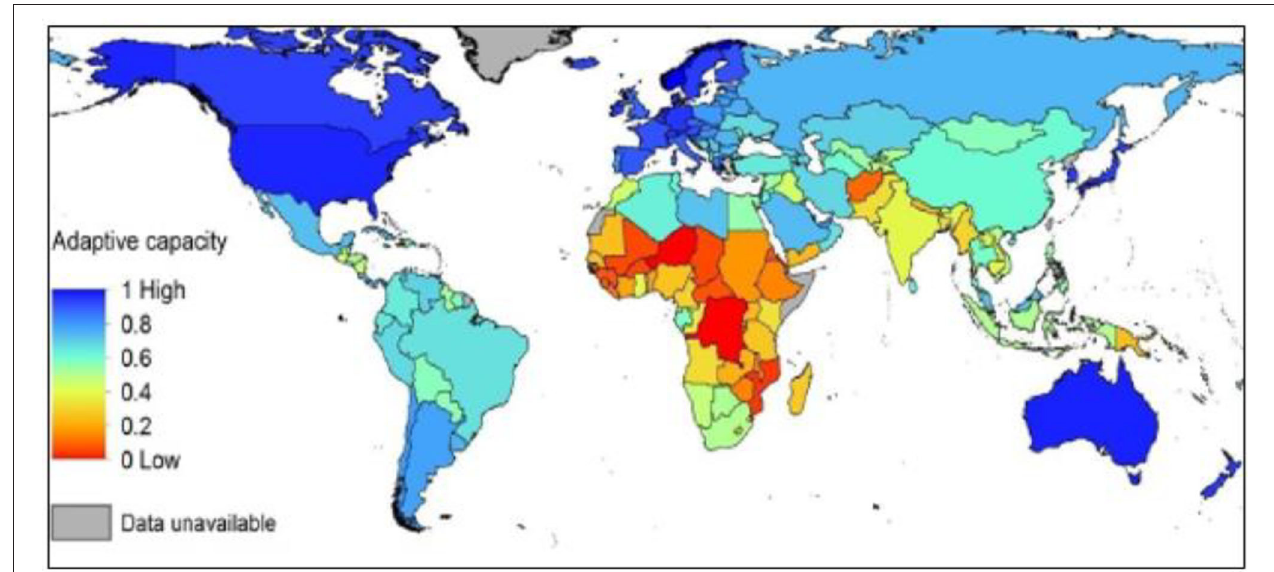
FIGURE 2 | World map showing the adaptive capacity of the nations to climate change effects on aquaculture. Source: Handisyde et al. (2017).